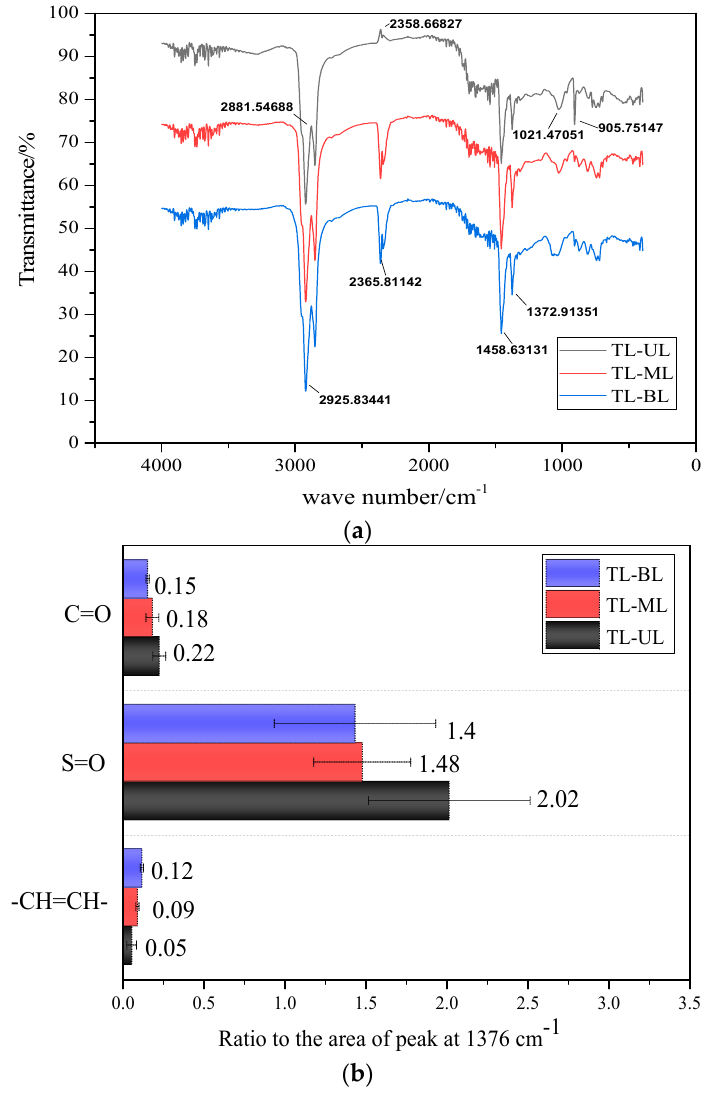
Figure 7. Composition changes of bitumen from TL-UL, TL-ML and TL-BL. ( a ) Infrared spectra; ( b ) quantitative analysis diagram. 195